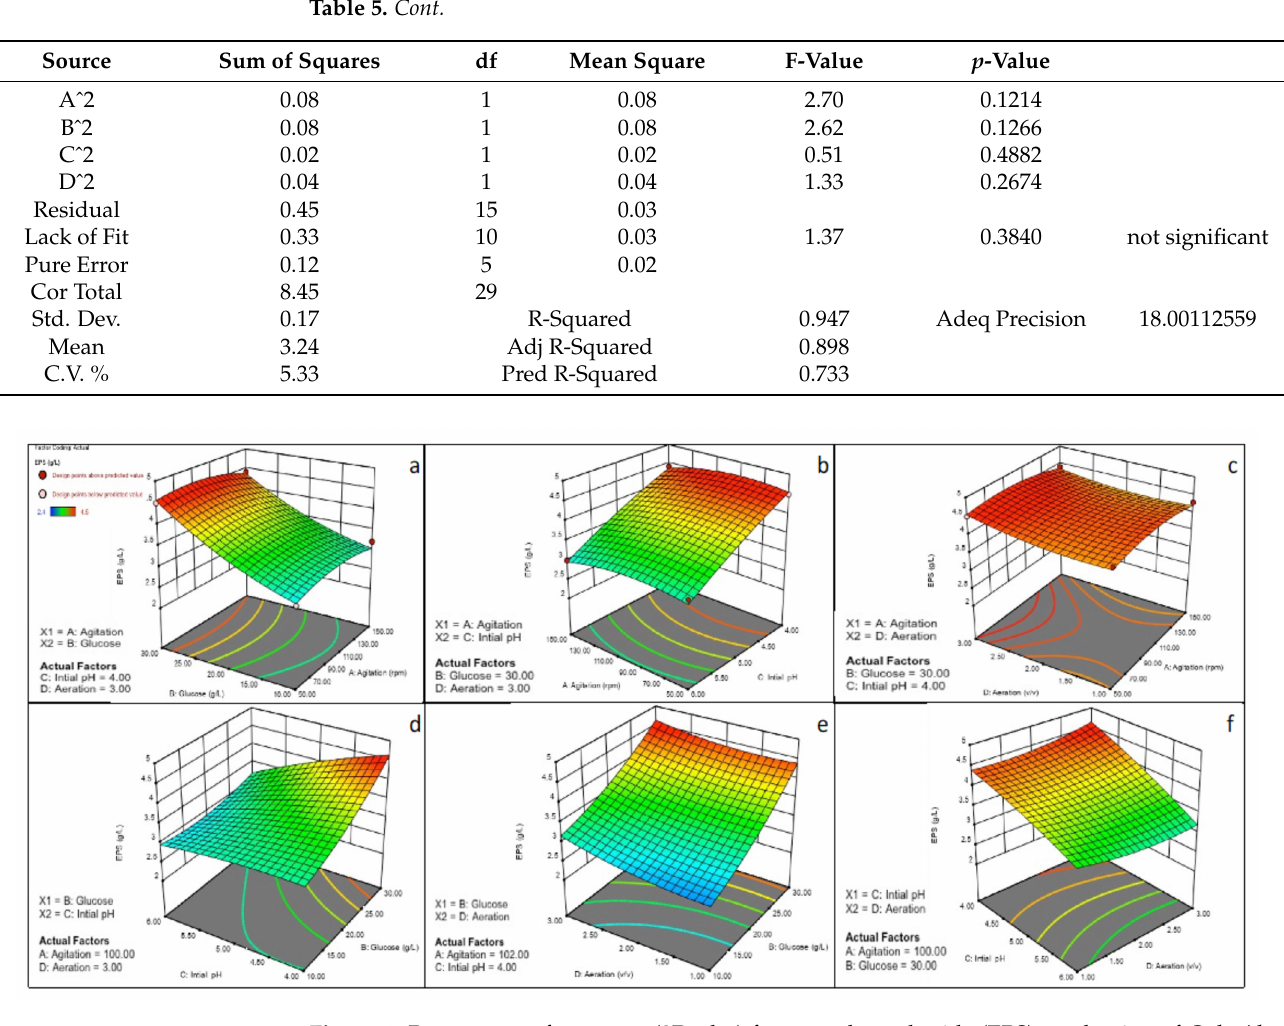
Figure 4. Response surface curve (3D plot) for exopolysaccharide (EPS) production of G. lucidum obtained from ALSB showing the interactions between ( a ) agitation and glucose, ( b ) agitation and pH, ( c ) agitation and aeration, ( d ) glucose and pH, ( e ) aeration and glucose, and ( f ) aeration and pH.